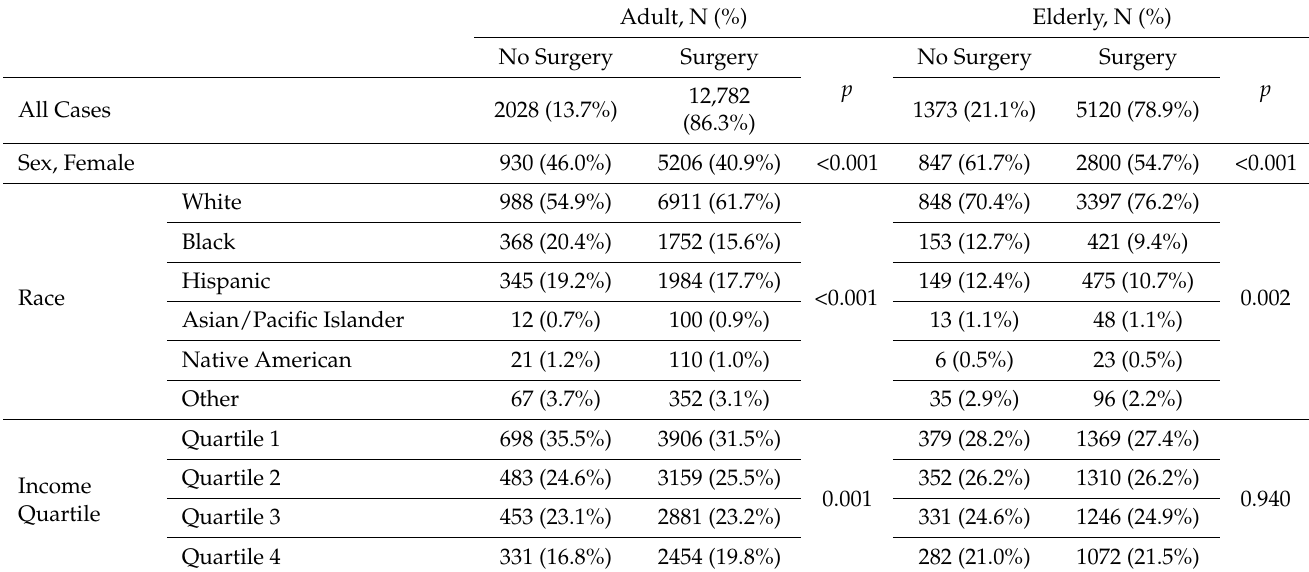
Table 4. Characteristics of emergently admitted patients with the primary diagnosis of umbilical hernia stratified based on surgical status, NIS 2005–2014. Data were stratified according to surgery status, NIS